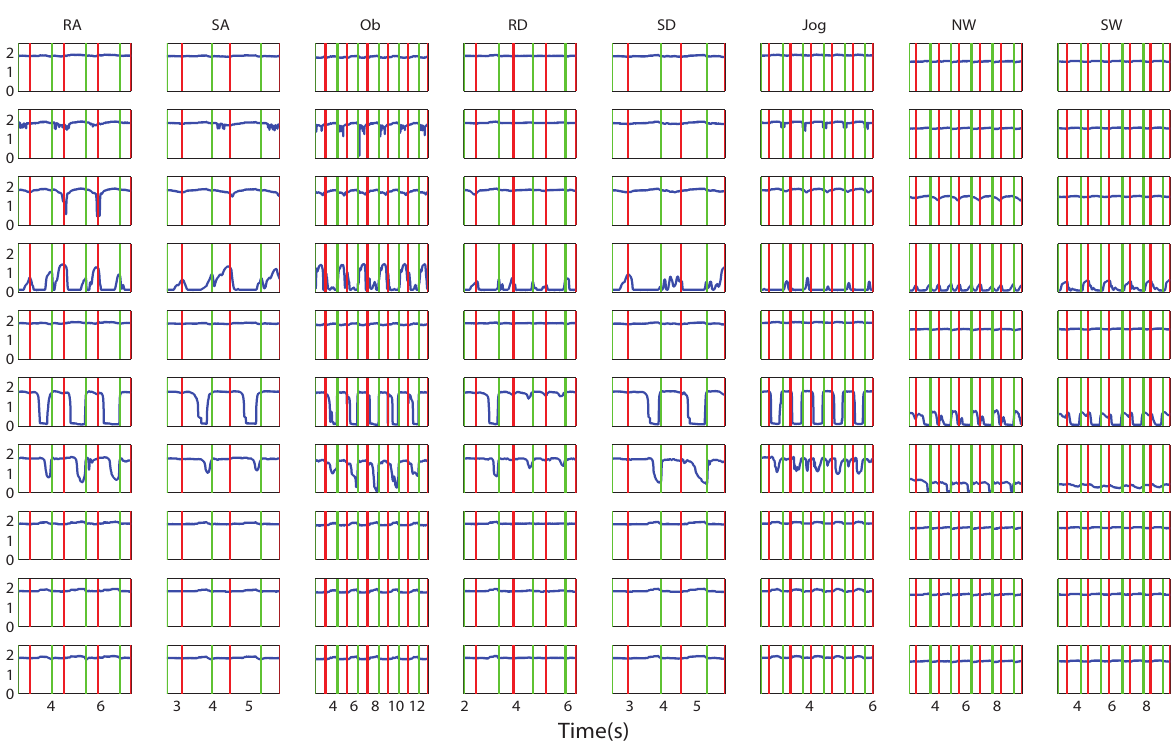
Figure 8. Capacitive signals of different locomotion modes. The x-axis is the time in seconds. The y-axis stands for the amplitude of the signals. The raw signals are shown as blue lines, while the red and green vertical lines stand for the gait events, foot contact (FC) and foot off (FO), respectively. Each row of the subfigures stands for one of the ten channels of the capacitance signals. Each column stands for a specific locomotion mode. The data for sitting, standing and squatting are steady lines with different amplitude, which are not shown in this